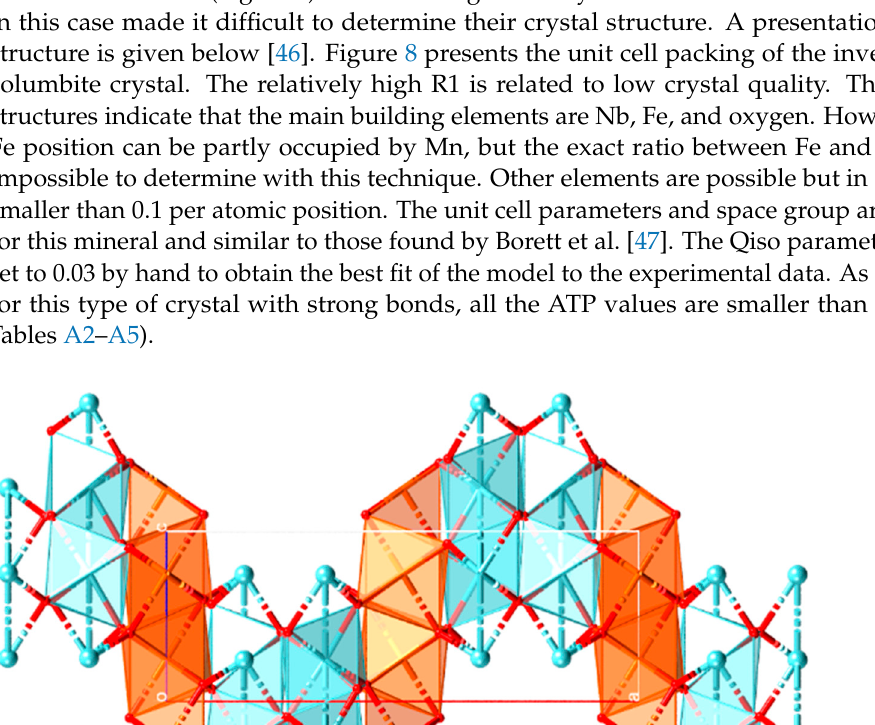
Figure 7. Raman spectrum for the columbite–tantalite crystals from Kolmozero.